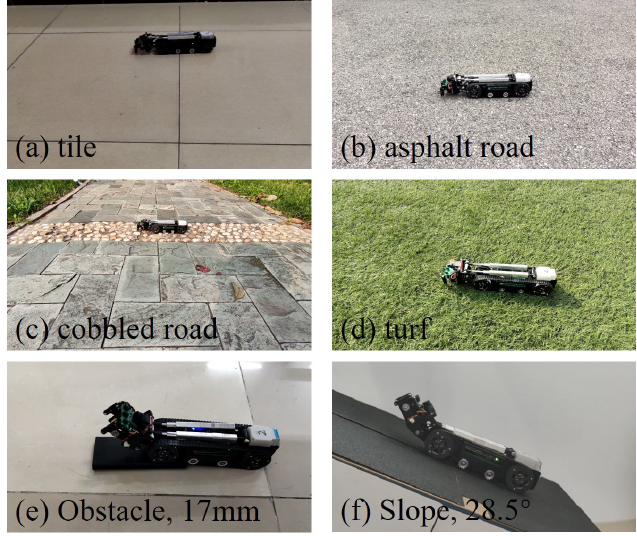
Figure 11. Trafficability of a single SMMRob on a variety of terrains and